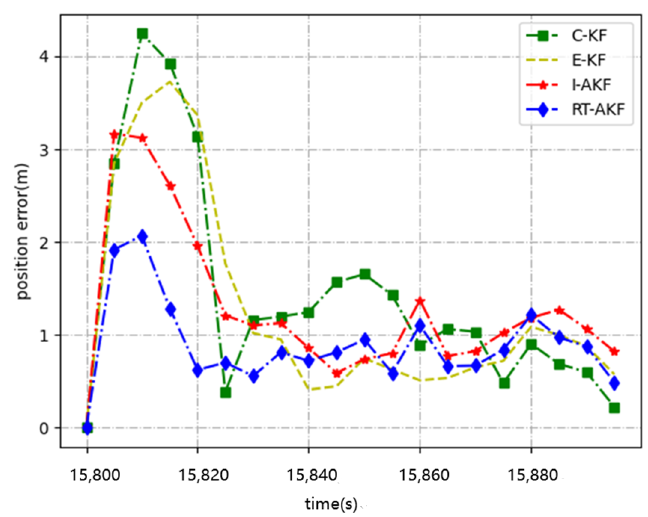
Figure 16. The positioning errors of GNSS/INS tightly coupled integrated by different methods in segment #5.